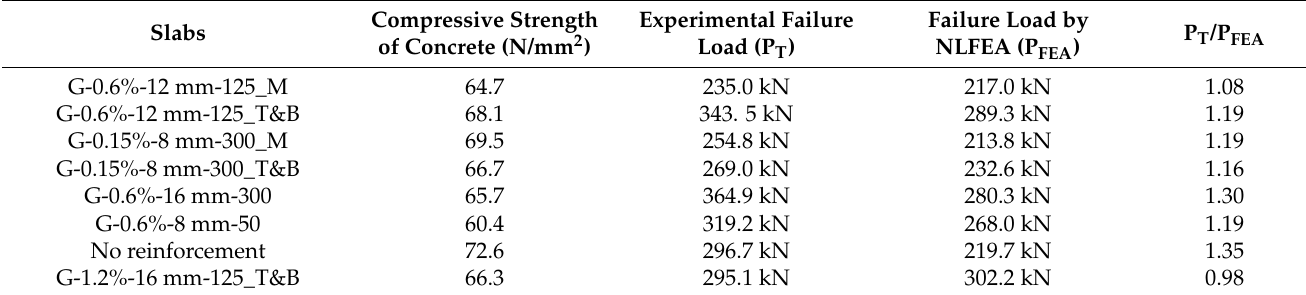
Table 5. Comparison of the experimental failure load with nonlinear finite element